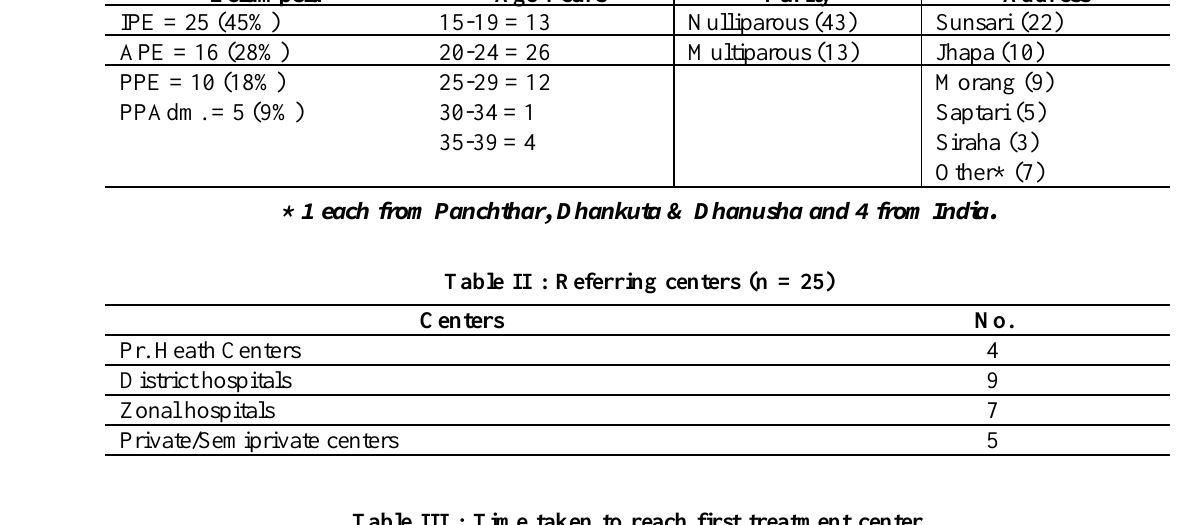
Table III : Time taken to reach first treatment center Time (hrs.)